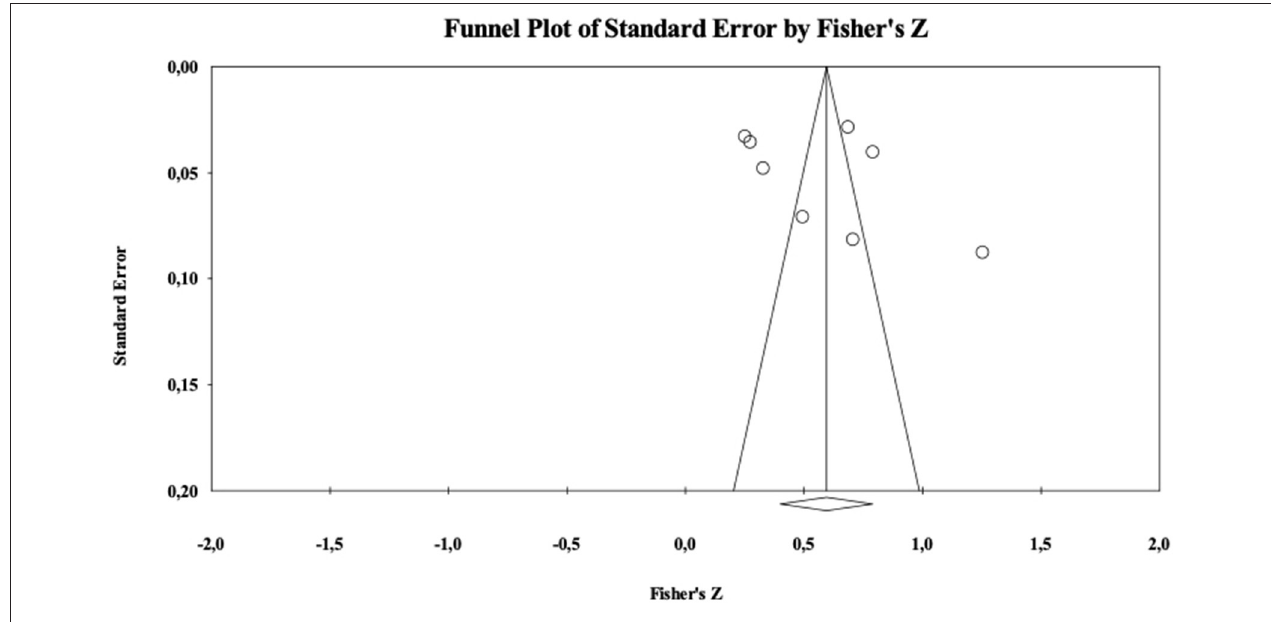
FIGURE 7 | Funnel plot for emotions.